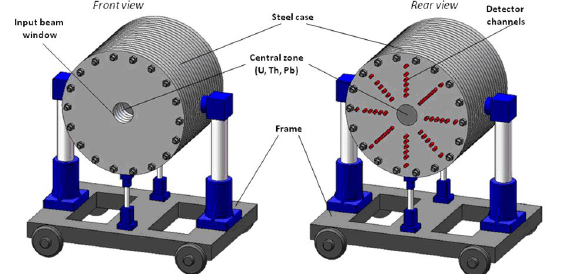
Figure 2. Schematic drawings of B-URAN, front and rear view [7]